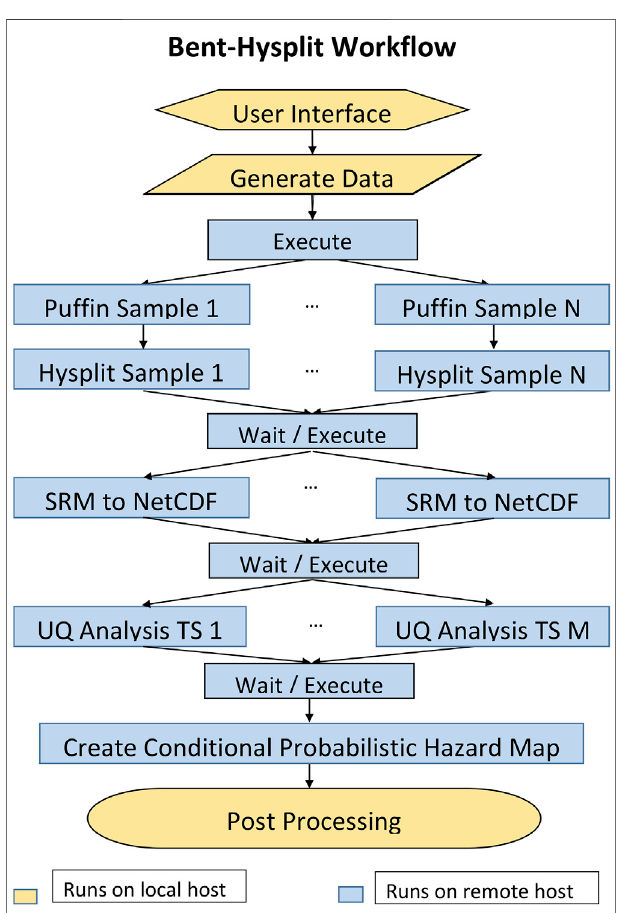
FIGURE 5 | Bent-Hysplit work fl ow tasks for ash clouds. Pegasus monitors the completion of task executions by determining when required output fi les are created by the